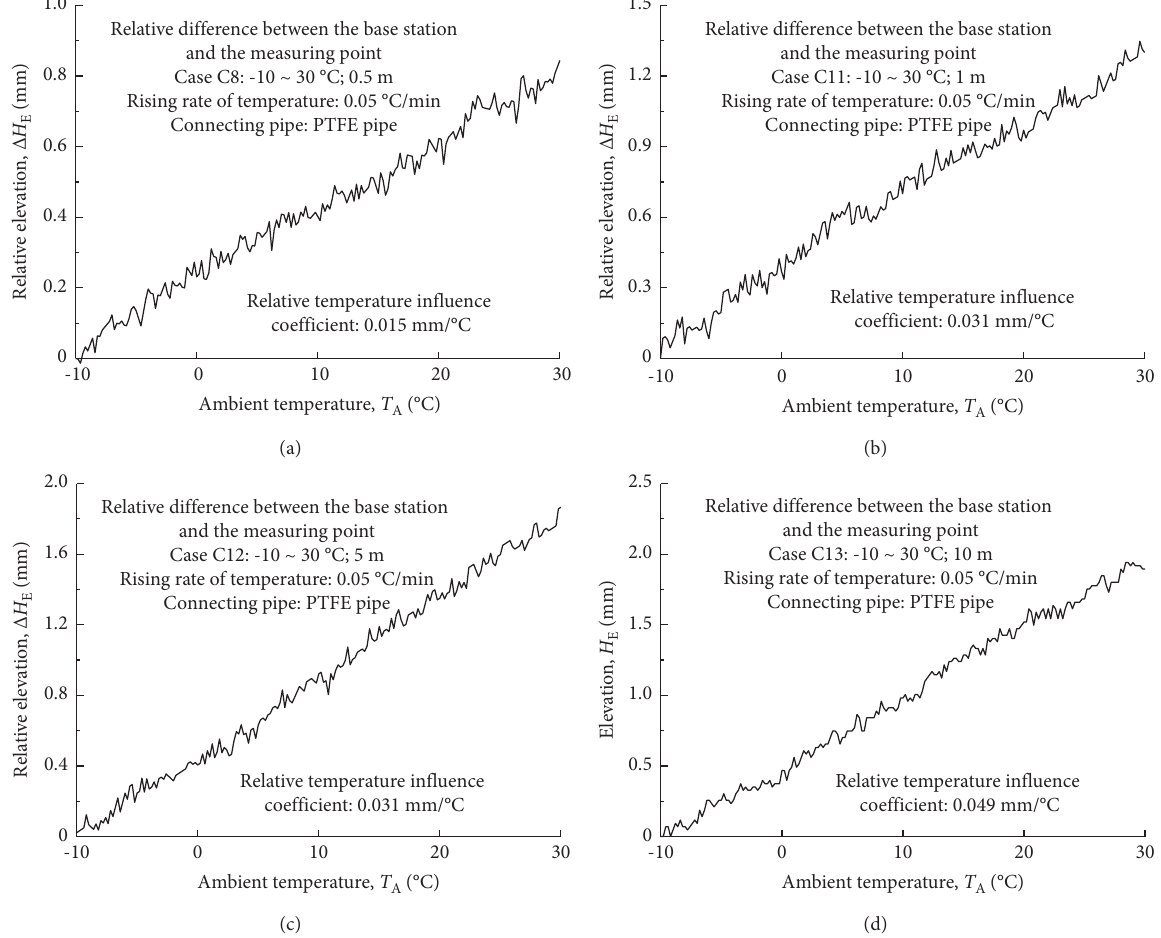
Figure 9: The relationship between relative elevation and ambient temperature under different measuring distances. (a) Case C8. (b) Case C11. (c) Case C12. (d) Case